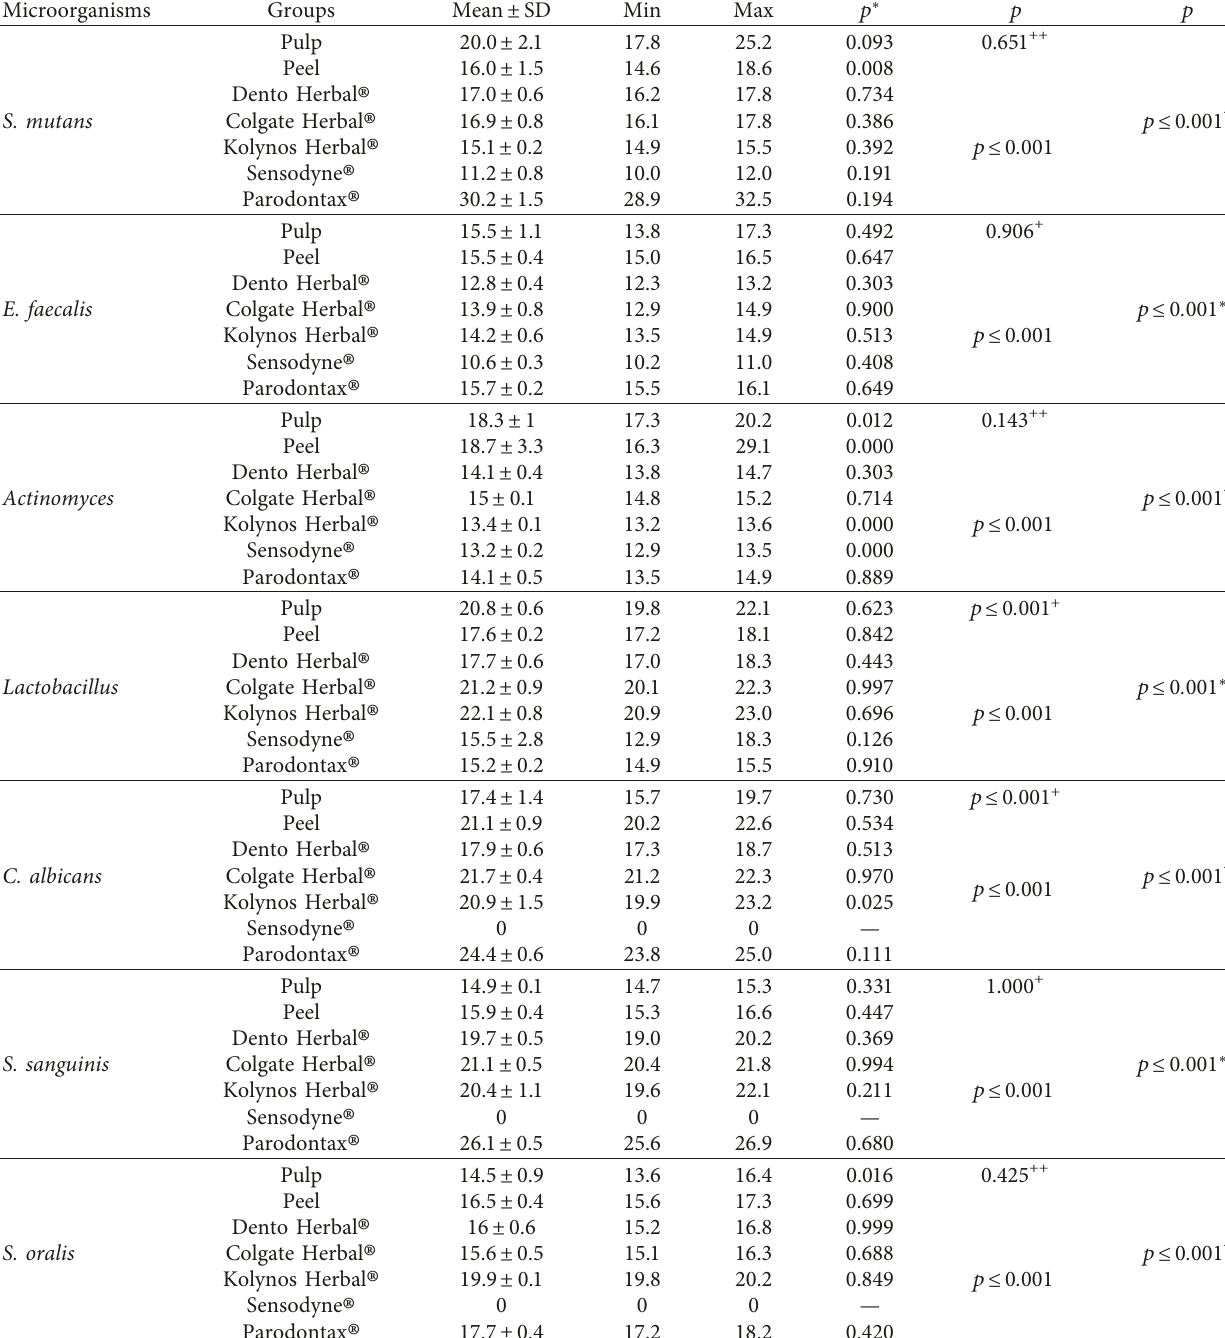
Table 4: Comparison of the antimicrobial activity of tumbo dentifrice against different commercial toothpastes. Microorganisms